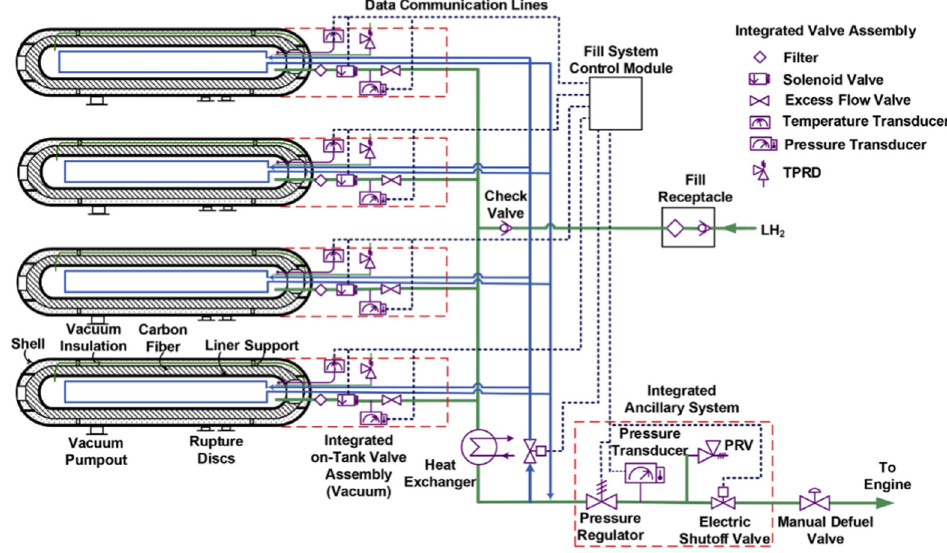
Figure 6. Onboard cryo-compressed hydrogen storage and supply system, LLNL. Reprinted/adapted with permission from Ref. [24], copyright 2018 Elsevier.